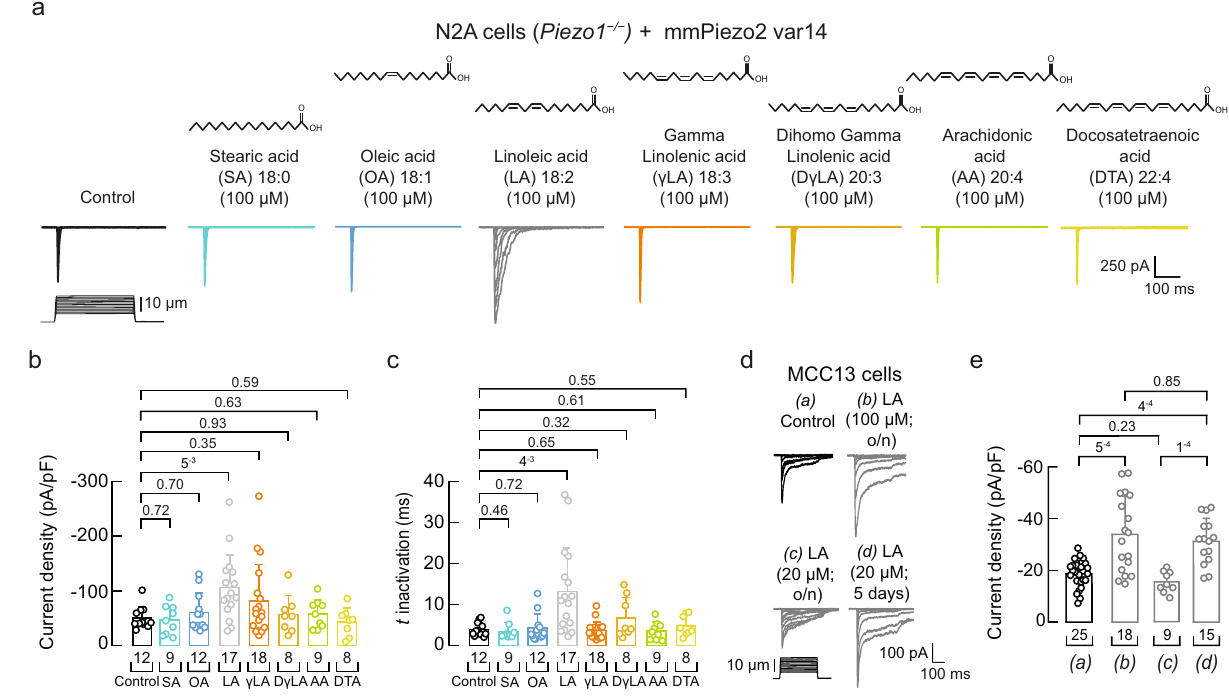
Fig. 4 | LA increases PIEZO2 activity in Piezo1 – / – N2A and MCC13 cells. a Representative whole-cell patch-clamp recordings of currents elicited by mechanical stimulation ( − 60 mV) in control, SA, OA, LA, γ LA, D γ LA, AA, and DTA (100 µ M; 24h)-treated Piezo1 – / – N2A cells transfected with Piezo2 variant 14 (var14). b Current densities elicited by maximum displacement of control or fatty acid- treated Piezo1 – / – N2A cells transfected with Piezo2 var14. Bars are mean±SD. Kruskal-Wallis (H=15.7; p =0.028) and Dunn ’ s multiple comparisons test. c Time constants of inactivation elicited by maximum displacement of control or fatty acid-treated Piezo1 – / – N2A cells transfected with Piezo2 var14. Bars are mean±SD.